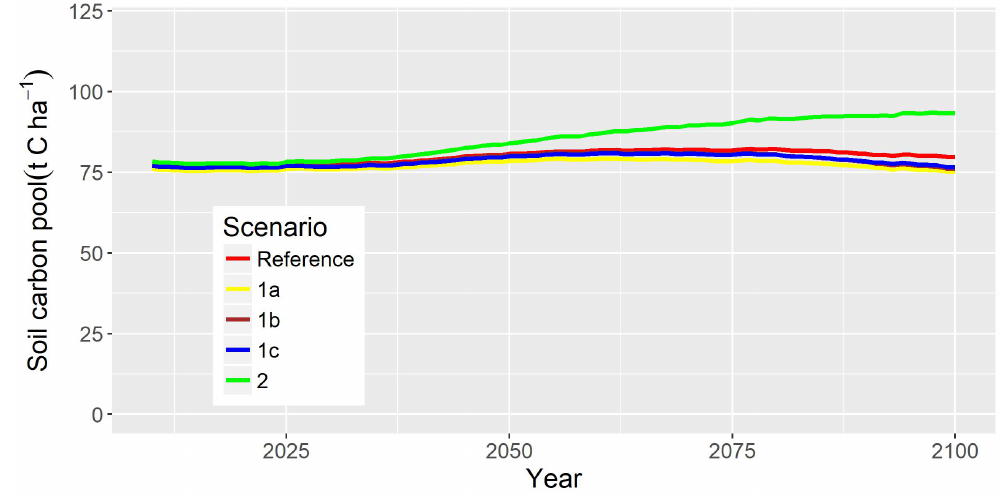
Figure 5. Development of the soil carbon pool in Austrian forests in different forest management